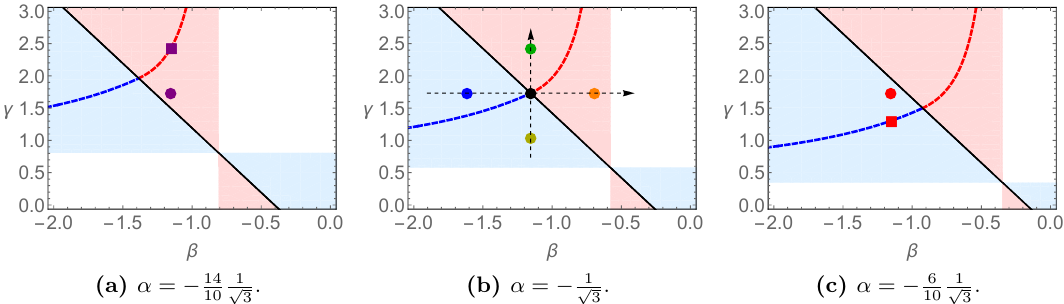
Figure 6. Allowed region of ( (cid:12); (cid:13) ) for a given (cid:11) < 0. In (cid:12)gure 7 we show the resistivity for the parameters corresponding to the dots in (a), (b), and (c). See the items 1-5 in sec, 5.2 for the meanings of colors, lines, and dots. In (cid:12)gure 8 we show the resistivity for the squares in (a) and (c).